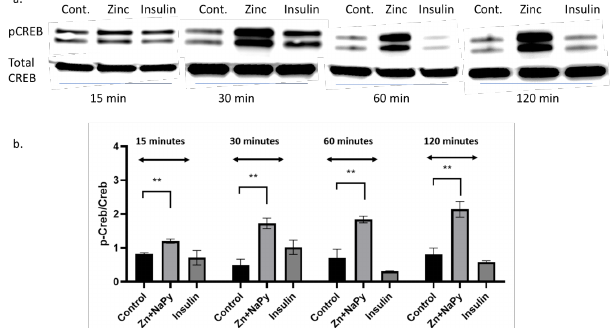
Figure 6. Western blot and densitometry of pCREB expression in C2C12 cells treated with zinc and insulin over 120 min. ( a ). Western blot of pCREB and total CREB treated with 20 µM zinc or 10 nM of insulin over 15, 30, 60, and 120 min. ( b ). Densitometry plot of pCreb / Creb from the Western blot data ( a ) from three independent experiments, ** = p < 0.01. Control = no treatment. Zn + NaPy = zinc plus sodium pyrithione.